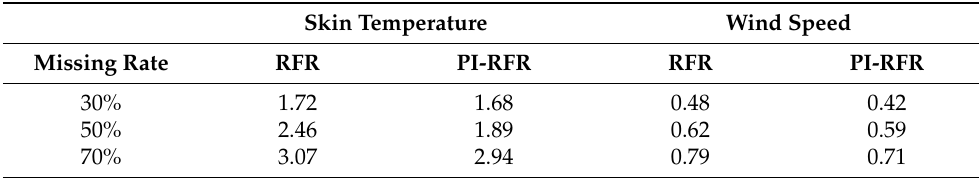
Table 2. Reconstruction performance (RMSE) of skin temperature and wind speed by RFR and PI-RFR methods under different missing rates. Skin Temperature Wind Speed Missing Rate RFR PI-RFR RFR PI-RFR